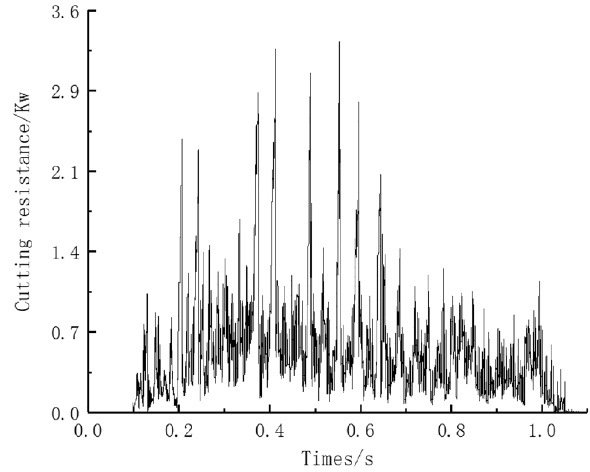
Figure 10. Cutting resistance curve.